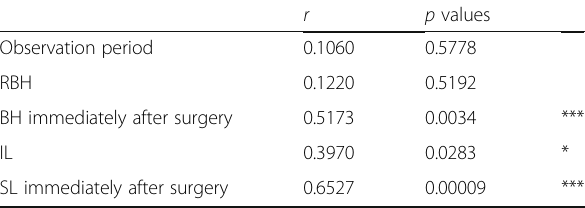
Table 4 Impact of each factor on the observed decrease in BH